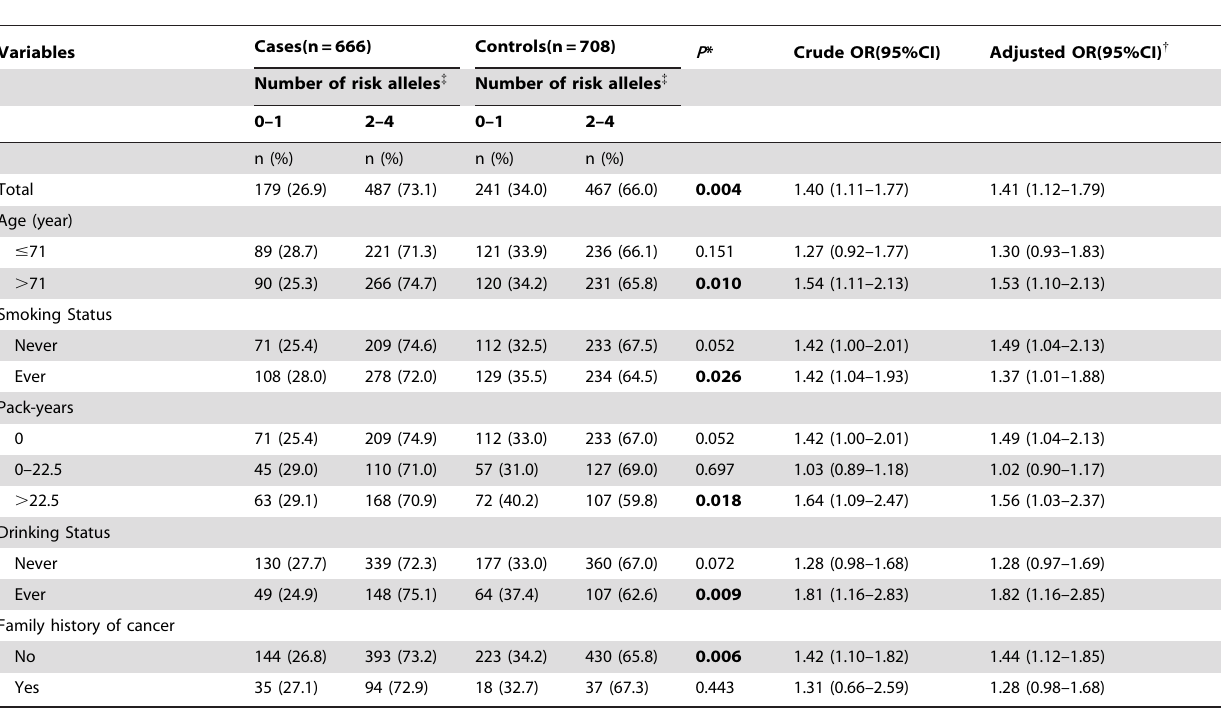
Table 4. Stratification analysis of the variant number of genotypes by selected variables in PCa patients and controls.